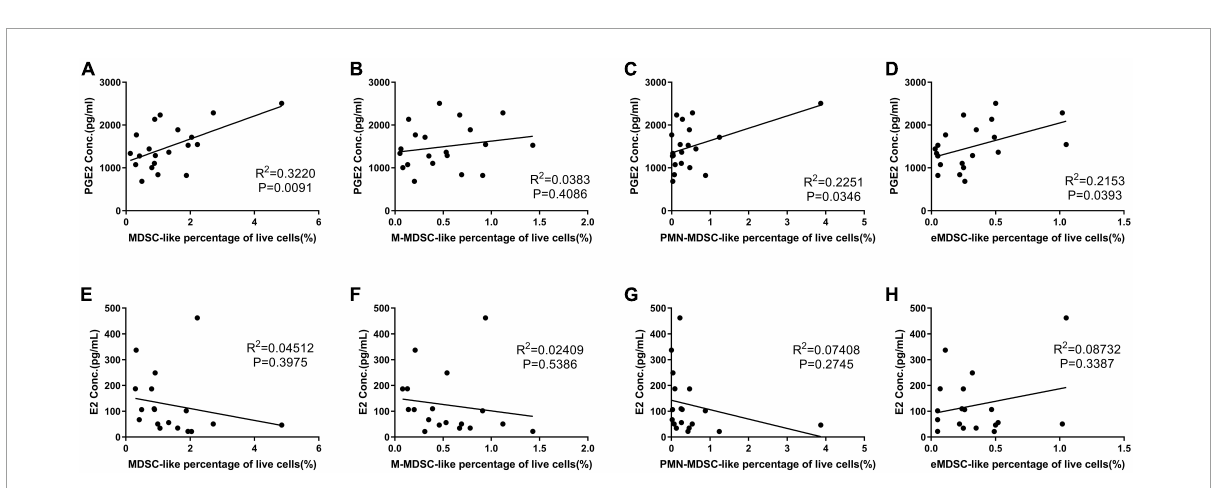
FIGURE4 The affect of prostaglandin estradiol (PGE2) and estradiol (E2) on myeloid-derived suppressor cell-like (MDSC-like) cells percentage. (A–D) Correlation between PGE2 concentration and MDSC-, monocytic-MDSC (M-MDSC-), granulocytic-MDSC (PMN-MDSC-), and early-stage-MDSC-like (eMDSC-like) cells percentage. (E–H) Correlation between E2 concentration and MDSC-, M- MDSC-, PMN- MDSC-, and eMDSC-like cells